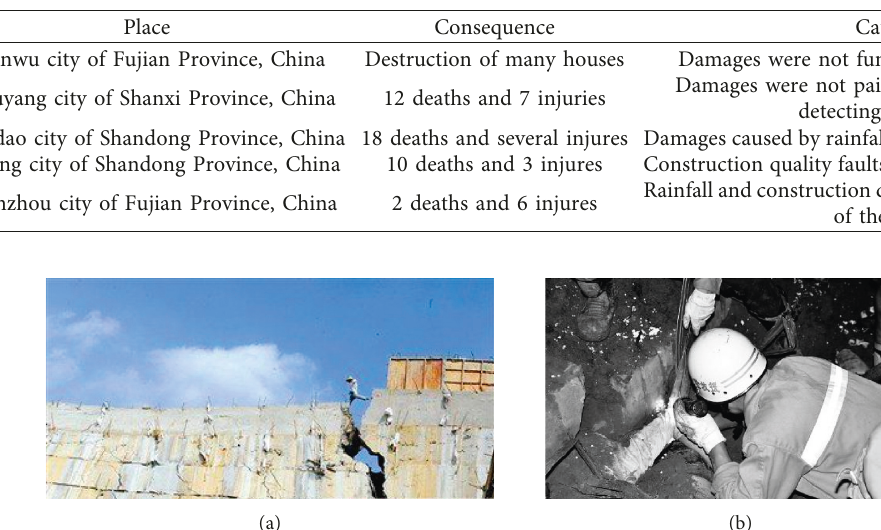
Table 1: Accidents of retaining wall collapse.